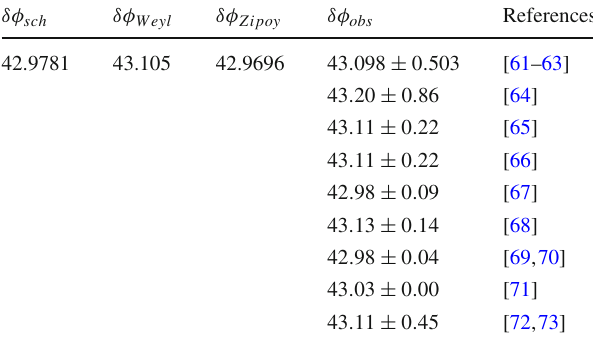
Table 1 Comparison between the values for secular precession of Mer- curyinunitsofarcsec/century( (cid:7)(cid:7) . cy − 1 )ofthestandard(Einstein)perihe- lionprecession δφ sch [26]andtheWeylconformastaticsolution δφ Weyl . The δφ obs stands for the secular observed perihelion precession in units of arcsec/century. In the fourth column, some observational values of perihelion precession are available. The first data point was adapted from [61] by adding a supplementary precession calibrated with the Ephemerides of the Planets and the Moon (EPM2011) [62,63] δφ δφ δφ sch Weyl Zipoy